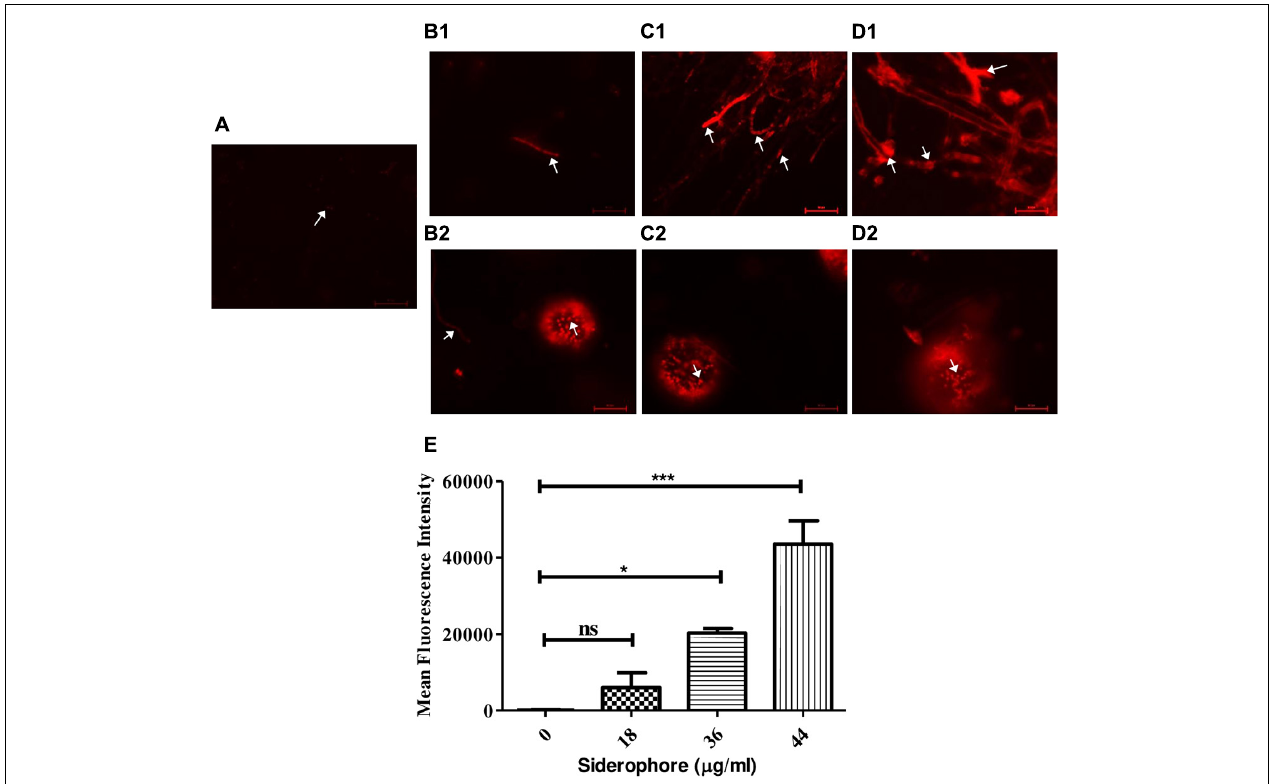
FIGURE 5 | Microphotographs of A. nidulans under various siderophore treatments after staining with propidium iodide (PI). (A) Control; (B1) Hyphae and (B2) conidial head of cultures treated with 18 µ g/ml of siderophore; (C1) Hyphae and (C2) conidial head of cultures treated with 36 µ g/ml of siderophore; (D1) Hyphae and (D2) conidial head of cultures treated with 44 µ g/ml of siderophore (arrows indicating cellular damage). (E) Mean fluorescent intensities from PI staining (ns—non-significant, *** p ≤ 0.001—highly significant, and * p ≤